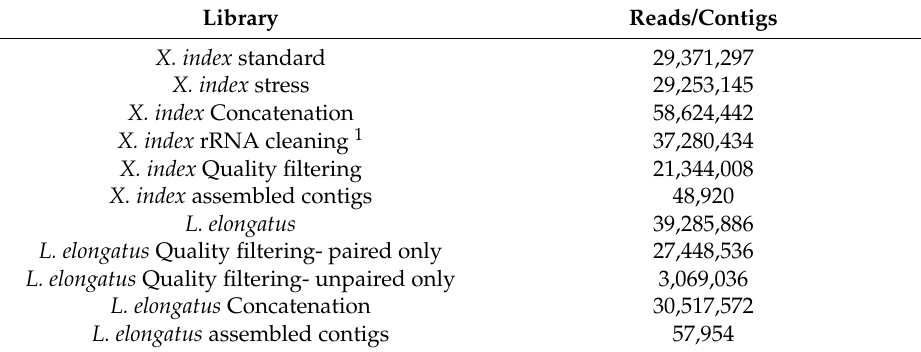
Table 1. Read statistics of Xiphinema index and Longidorus elongatus transcriptome